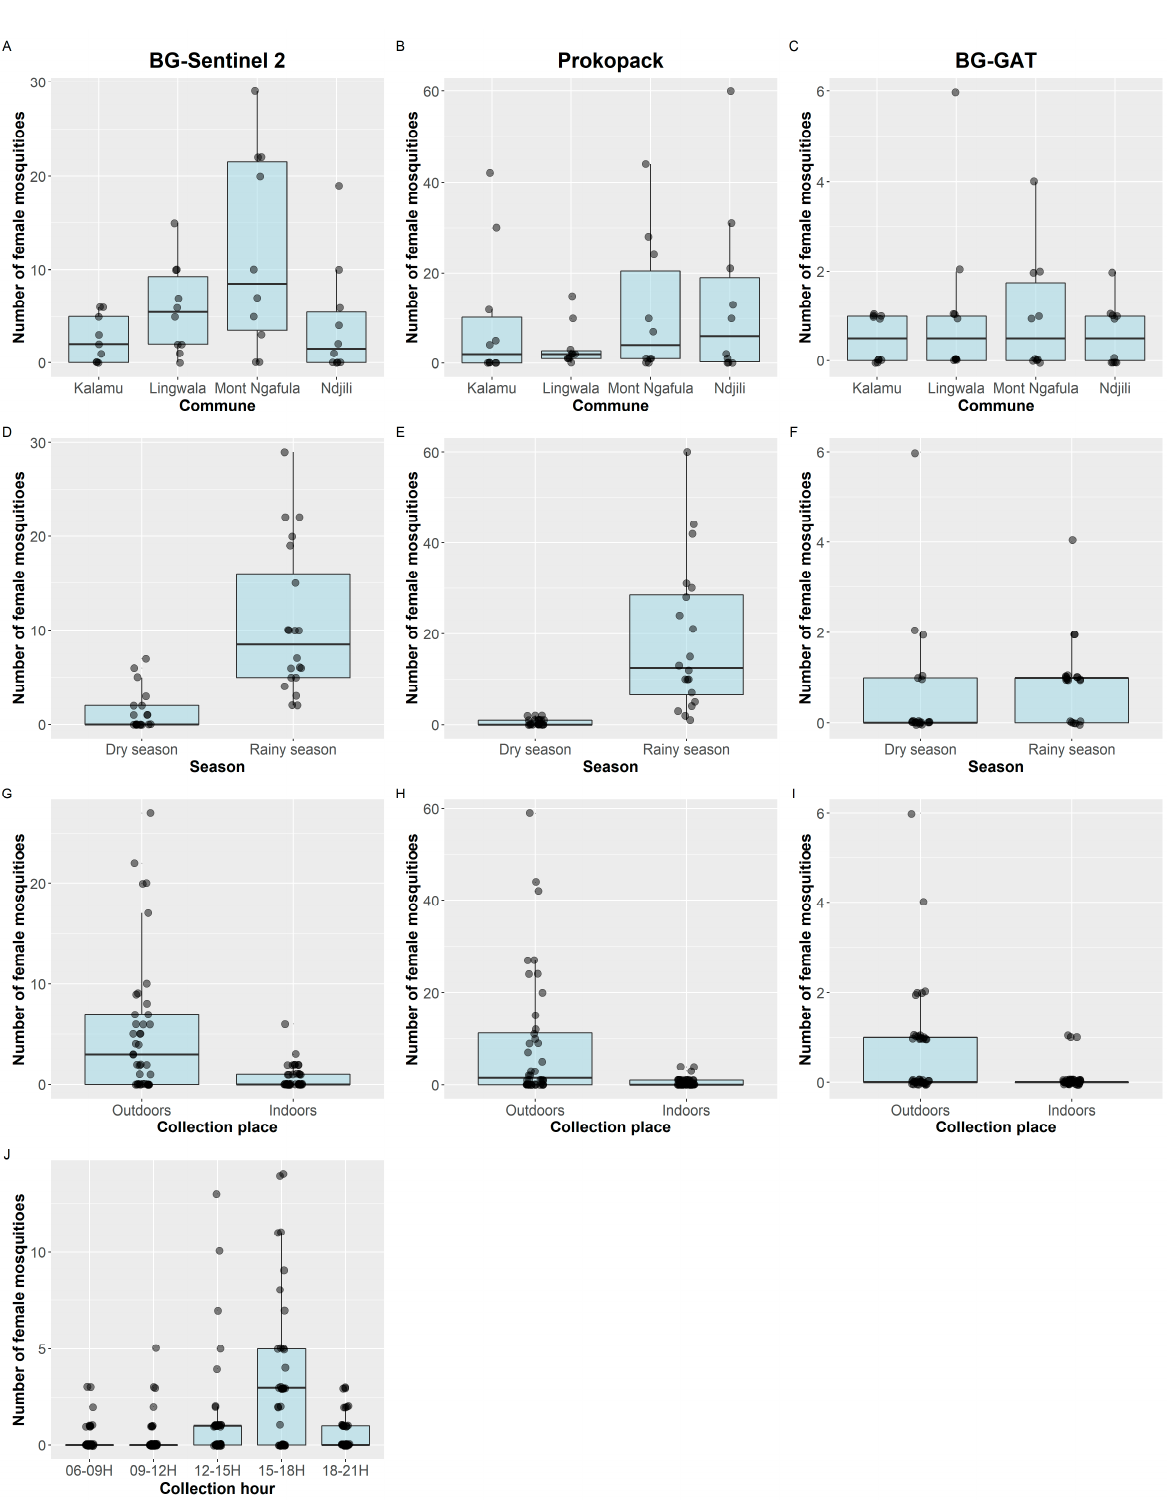
Figure 1. Number of female Aedes aegypti mosquitoes collected per day (dots), summarized by commune ( A – C ), season (collection surveys) ( D – F ), collection places ( G – I ), and collection time ( J ). The boxplots provide an overview of the medians and interquartile ranges. Column 1 provides data from the BG-Sentinel 2 collections, column 2 from the prokopack collections, and column 3 from the BG-GAT collections. Note. The scales of the y -axes are adjusted in each panel to enable interpretation of the